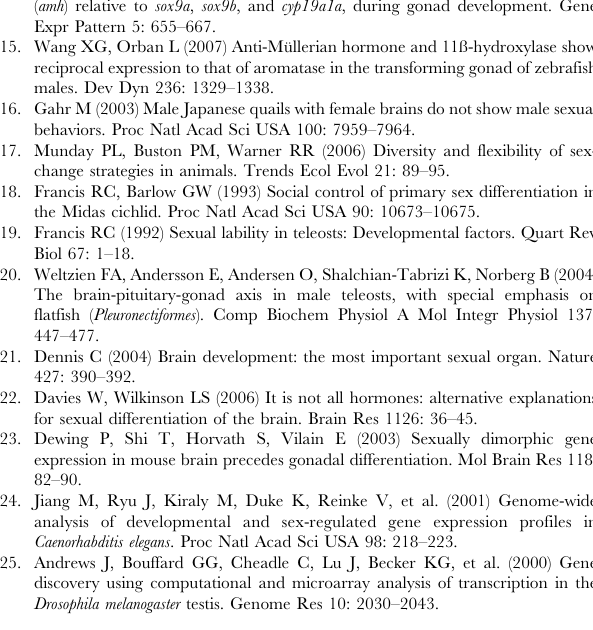
Table S7 List of highly-expressed ovary and testis genes analyzed by in situ hybridization (ISH). Normalized intensities for ovary (FO) and testis (MT) targets and ratios of normalized intensities of FO/MT (or vice versa) are shown.